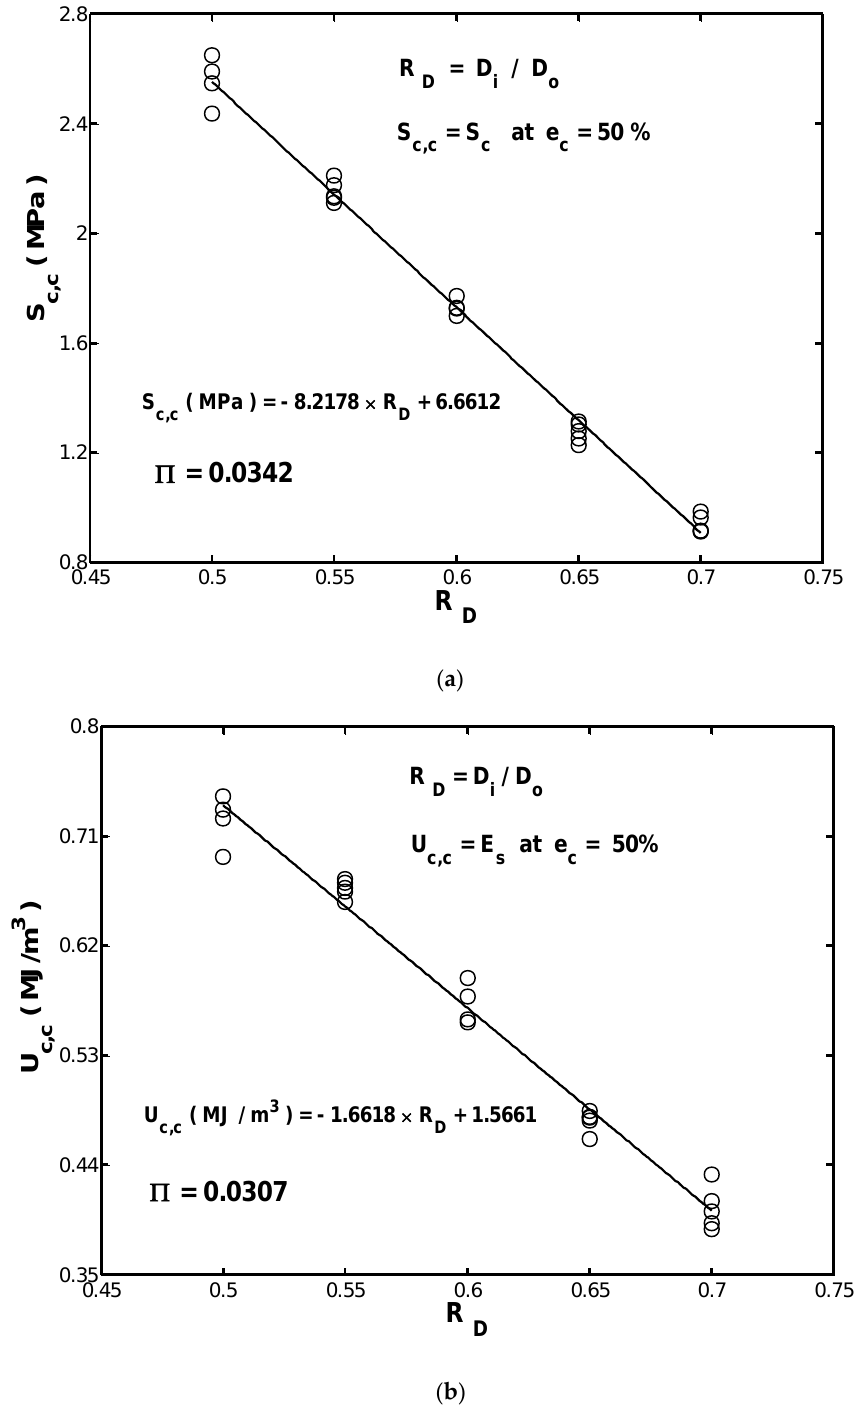
Figure 6. Measured data and linearly fitted results for ( a ) =compression strength 𝑆 𝑐,𝑐 and ( b ) Figure6. Measureddataandlinearlyfittedresultsfor( a ) = compressionstrength S c , c and( b )compression compression toughness 𝑈 𝑐,𝑐 for fenders with a diameter ratio 𝑅 𝐷 ranging from 0.5 to 0.7. toughness U c , c for fenders with a diameter ratio R D ranging from 0.5 to